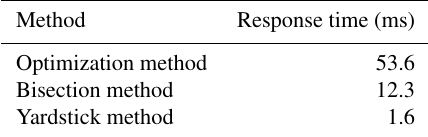
Table 2. Computation time